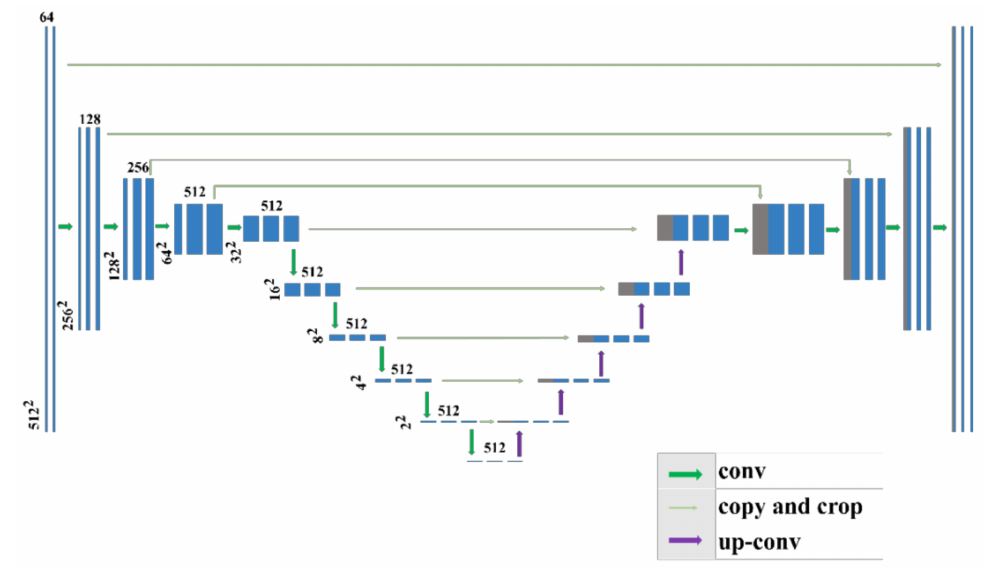
Figure 2. Modified U-net